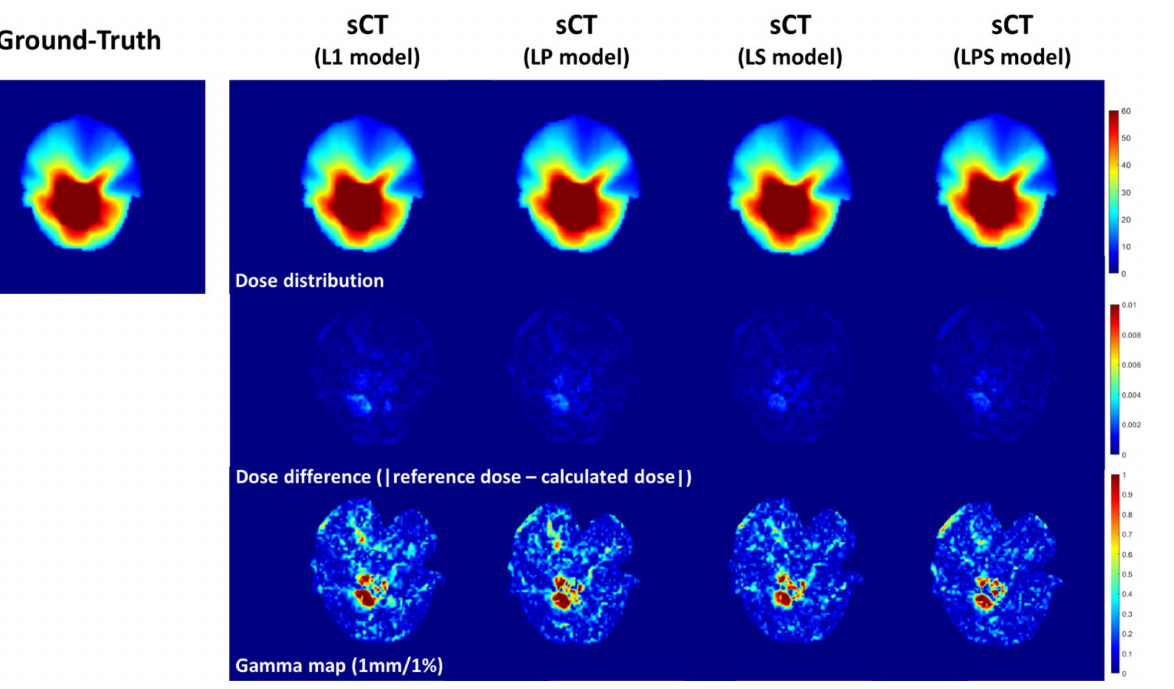
Figure 4. Example of dose distributions and dose differences. Ground-Truth, synthetic CT(L1 loss), synthetic CT(LP loss), synthetic CT(LS loss), and synthetic CT(LPS loss) from axial plane from Patient 3 in the 10 test